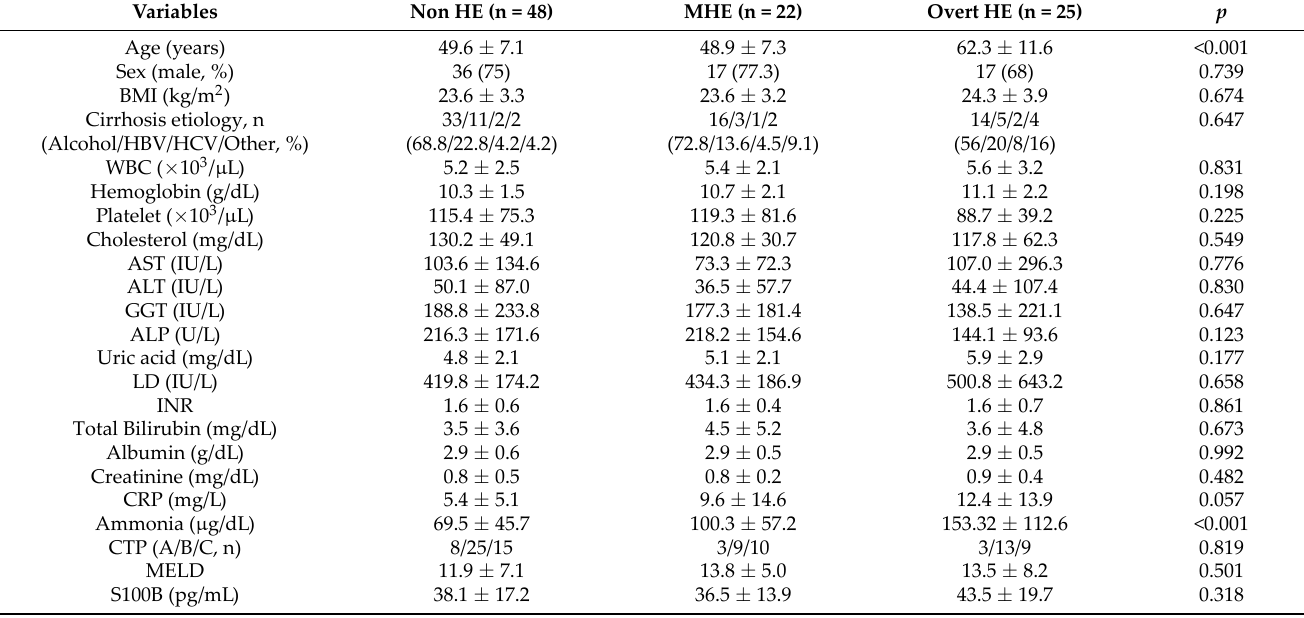
Table 2. Comparison of clinical characteristics of the study